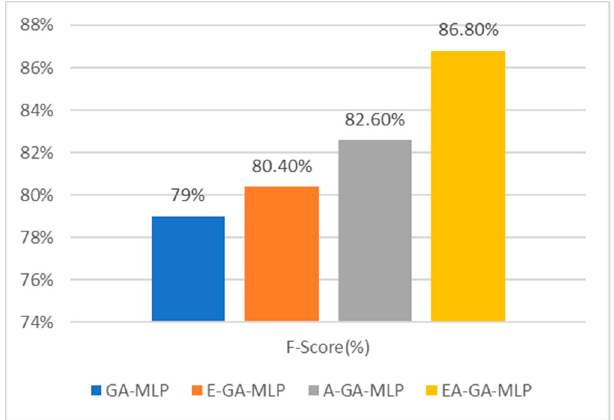
Figure 9. Comparative analysis of F-Score of presented Algorithm EAGA with its subcomponents.